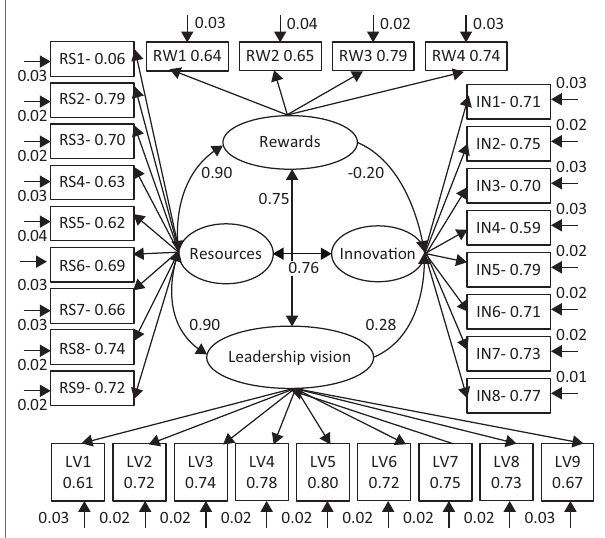
FIGURE 4: The structural equation